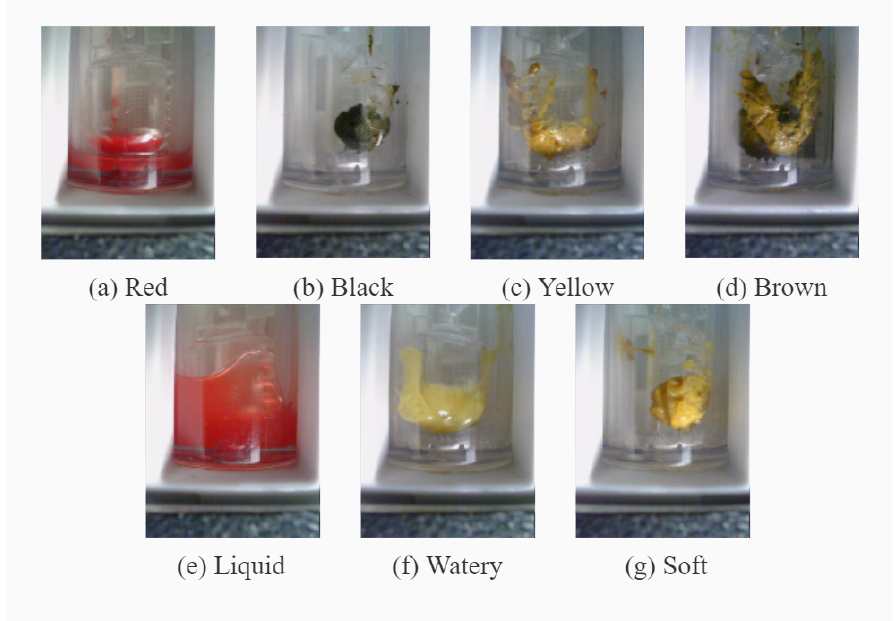
Figure 1. Categories of feces images: ( a – d ) for color classification and ( e – g ) for trait